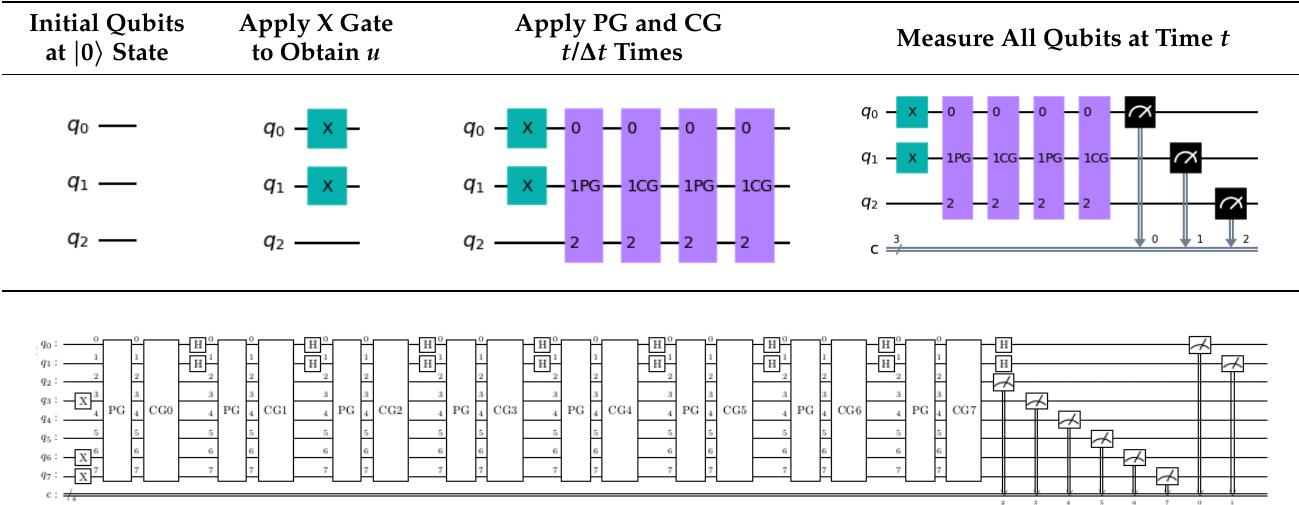
Table 9. Quantum circuit in Qiskit.